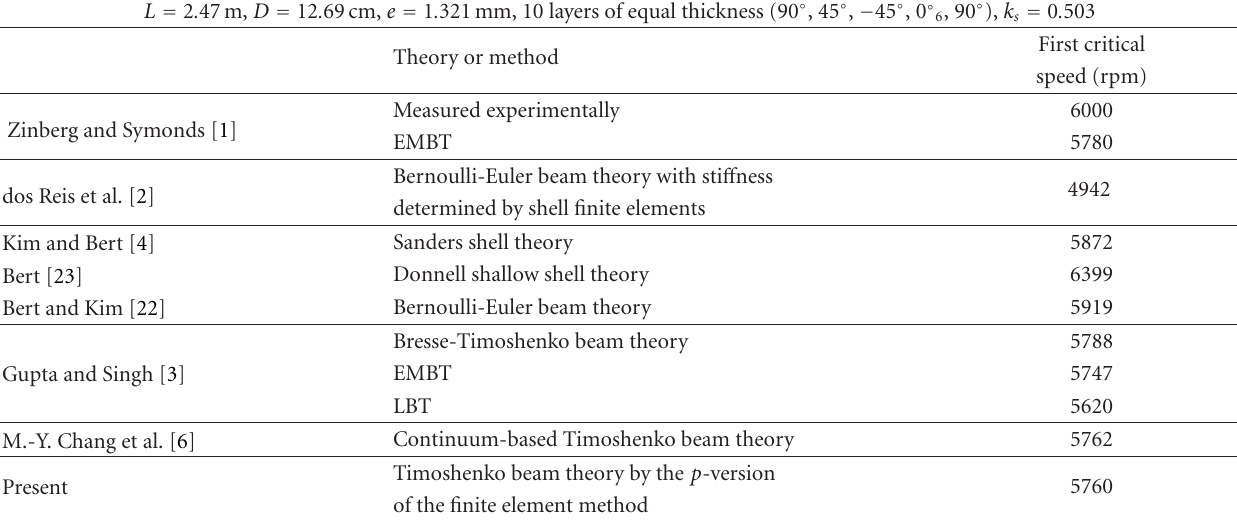
Table 2: The critical speed of the boron-epoxy composite